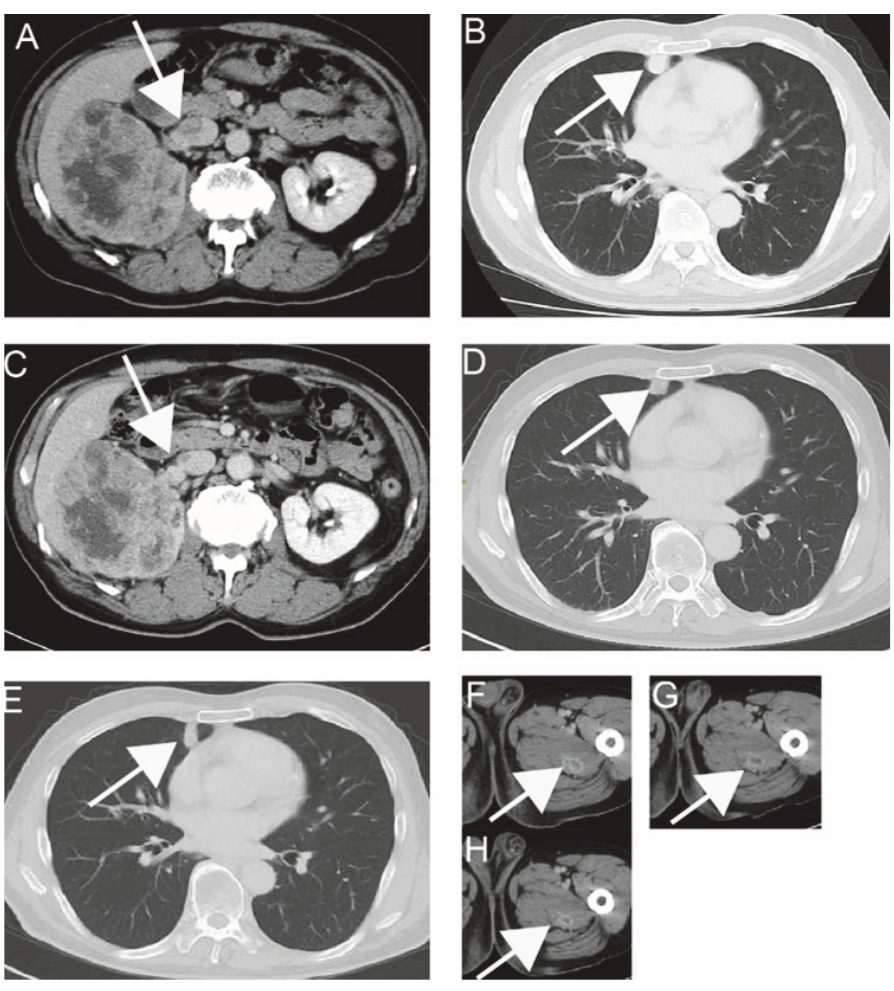
Figure 1: Computed tomography (CT) finding of primary site (A, C), lung metastasis (B, D, E), and intramuscular metastasis (F-H) . Hypervascular renal tumor with liver invasion, IVC extension (arrowhead, left), and lung metastasis (arrowhead, right) were observed. After a month of presurgical treatment, tumor thrombus and lung metastasis had decreased (A-B, F: before treatment, C-D, G: after treatment). CT appearance of lung metastasis and that of intramuscular metastasis at 18 months after surgery are shown (E, H).